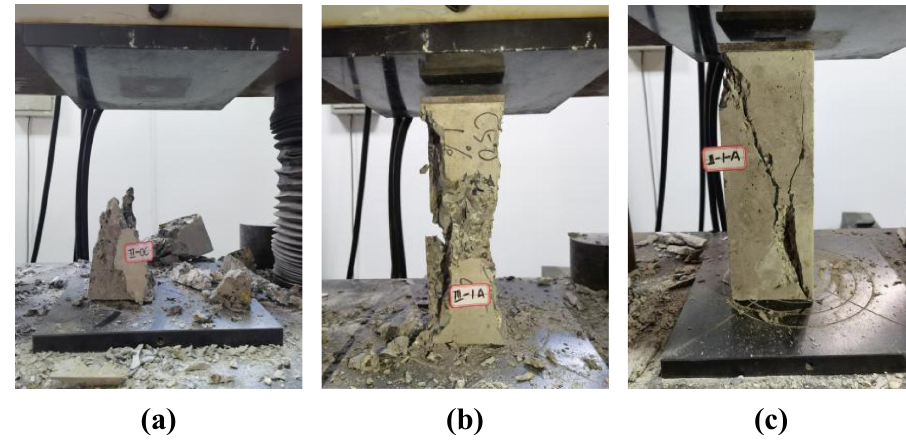
Figure 17: Failure mode of concrete axial compressive strength: ( a ) NC, ( b ) PSFC, and ( c )